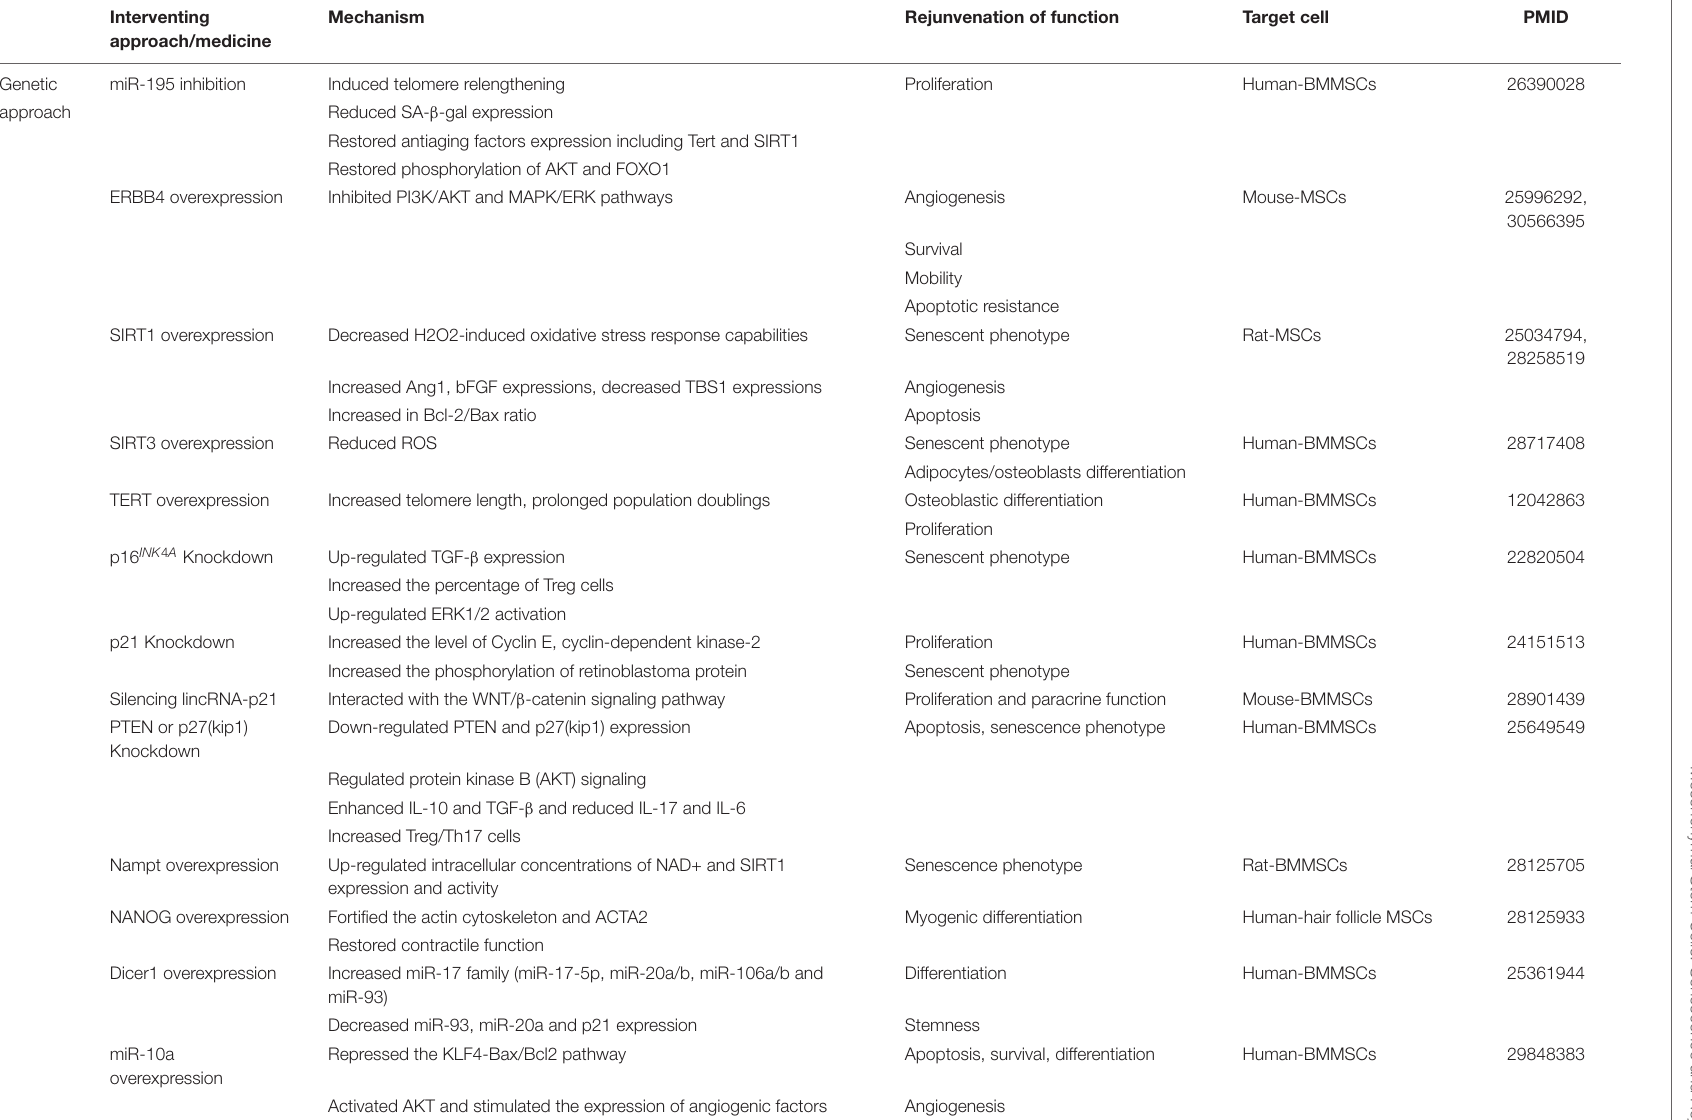
TABLE 3 | Strategies for MSC